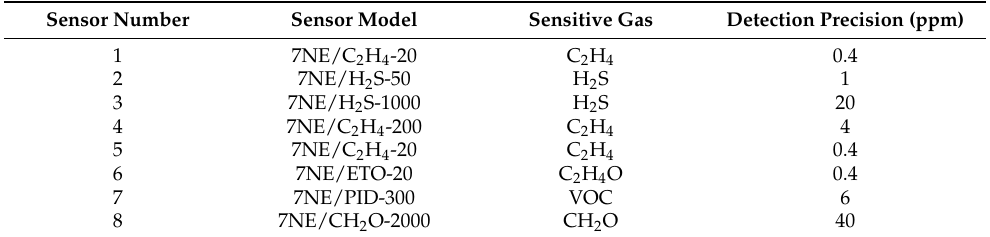
Table 1. Types of gas-sensitive sensors in the portable electronic nose sensor array, and their sensitive gas and detection accuracies.